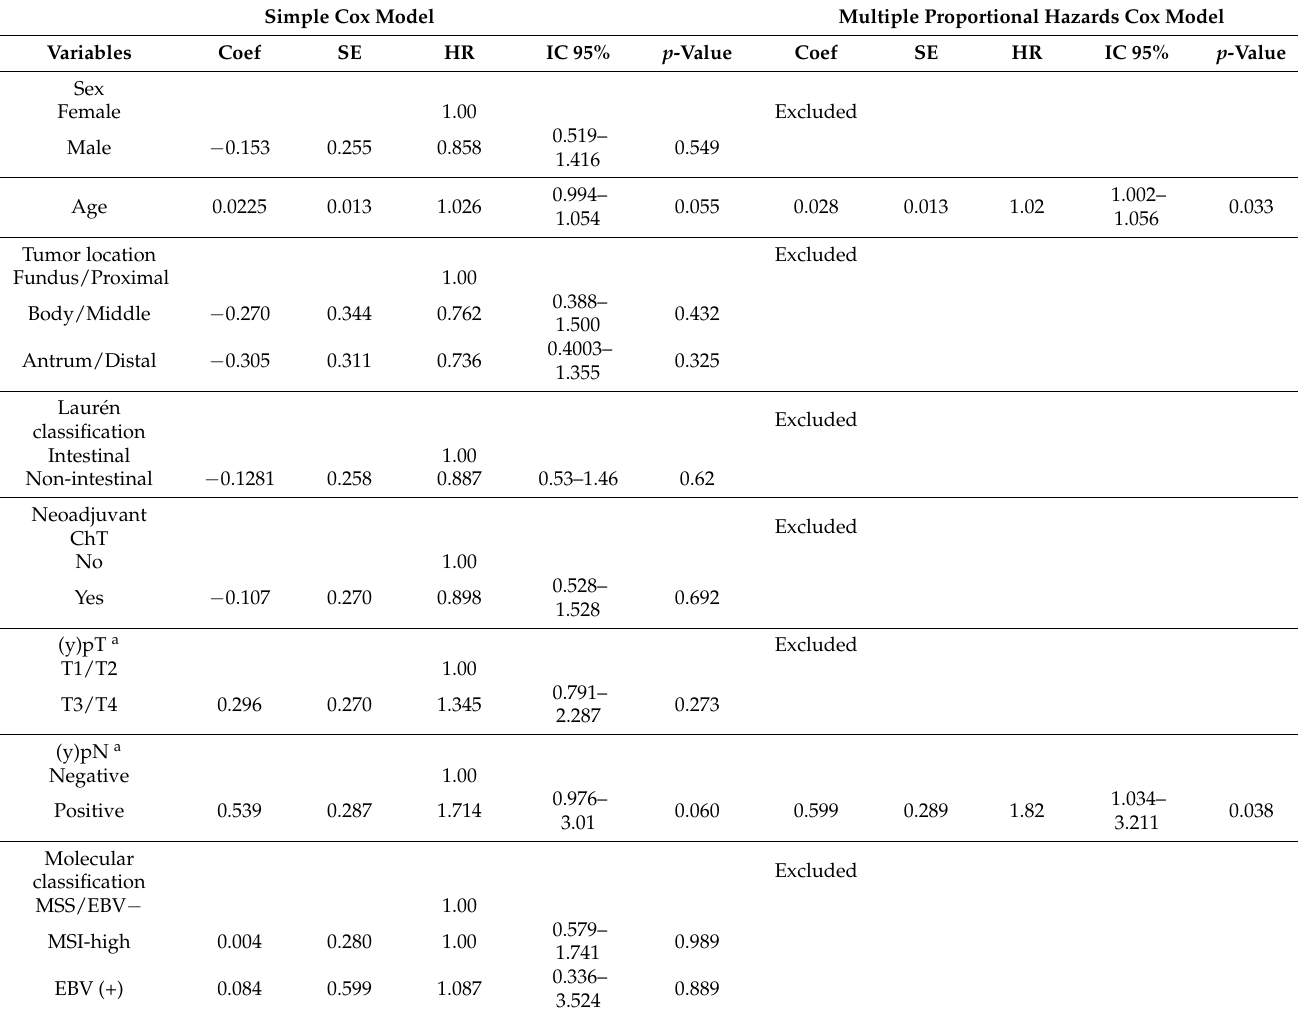
Table 4. Simple and multiple Cox proportionalhazards model for analysis of the OS of patients with operated localized